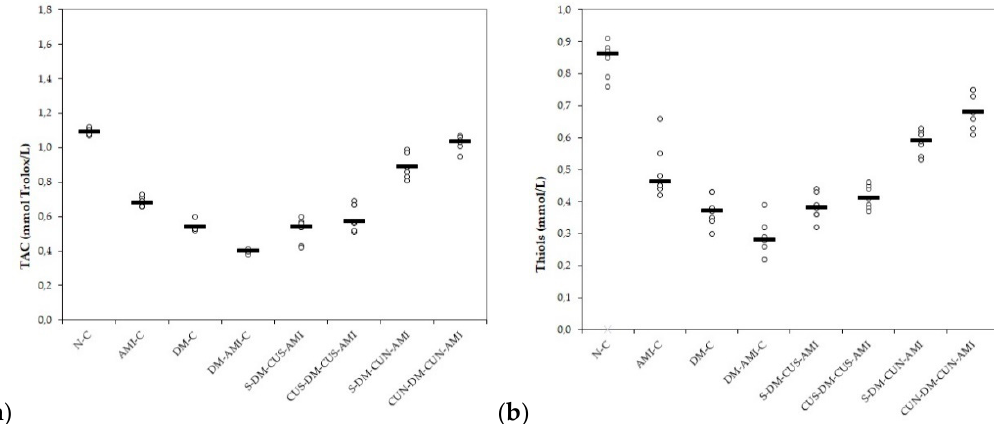
Figure 3. Variation by groups of serum antioxidant capacity: ( a ) TAC (total antioxidant capacity) and ( b ) thiols by groups. Notes: The circles represent the individual values, and the horizontal line is given by the median. Abbreviations: N = normal; C = control; AMI = acute myocardial infarction; DM = diabetes mellitus; S = saline; CUS = curcumin solution in a dose of 200 mg / kg bw; CUN200 = curcumin nanoparticles solution in a dose of 200 mg / kg